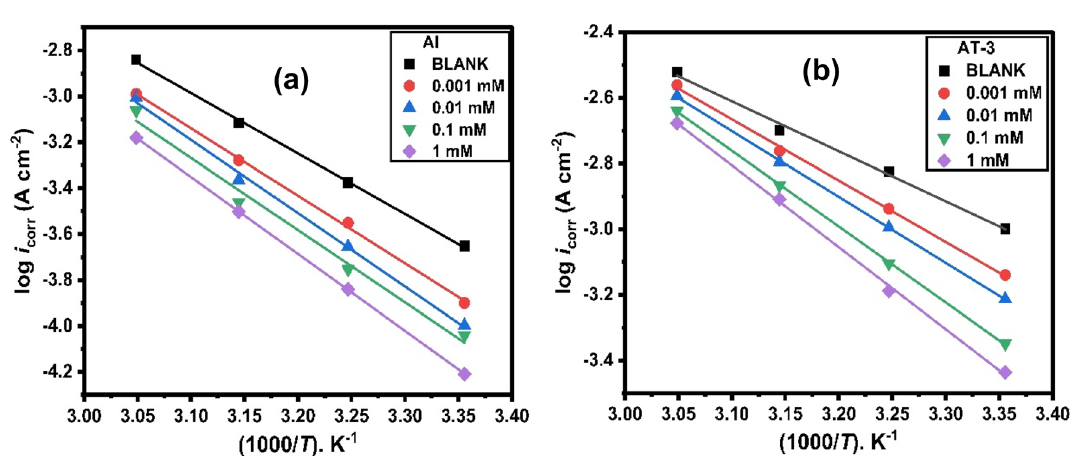
Figure 7. Arrhenius plots for ( a ) Al and ( b ) AT-3 alloy after 30 min of exposure to 0.5 M HCl with different concentrations of 2-MBT at different